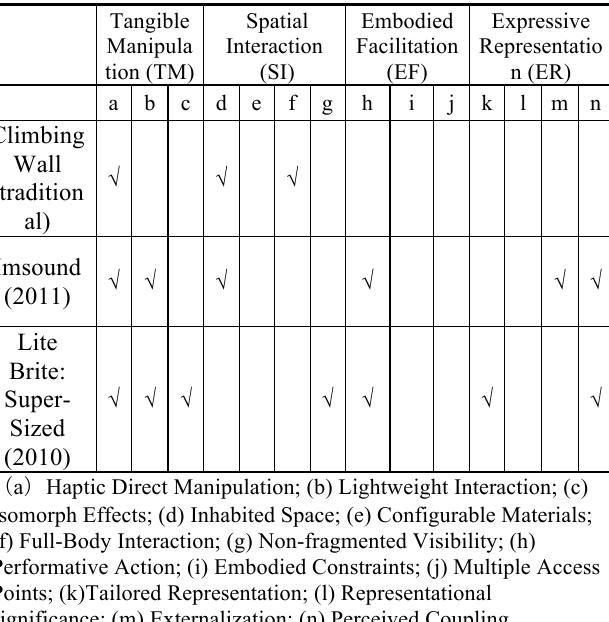
Table 1. Case study based on Tangible Interaction